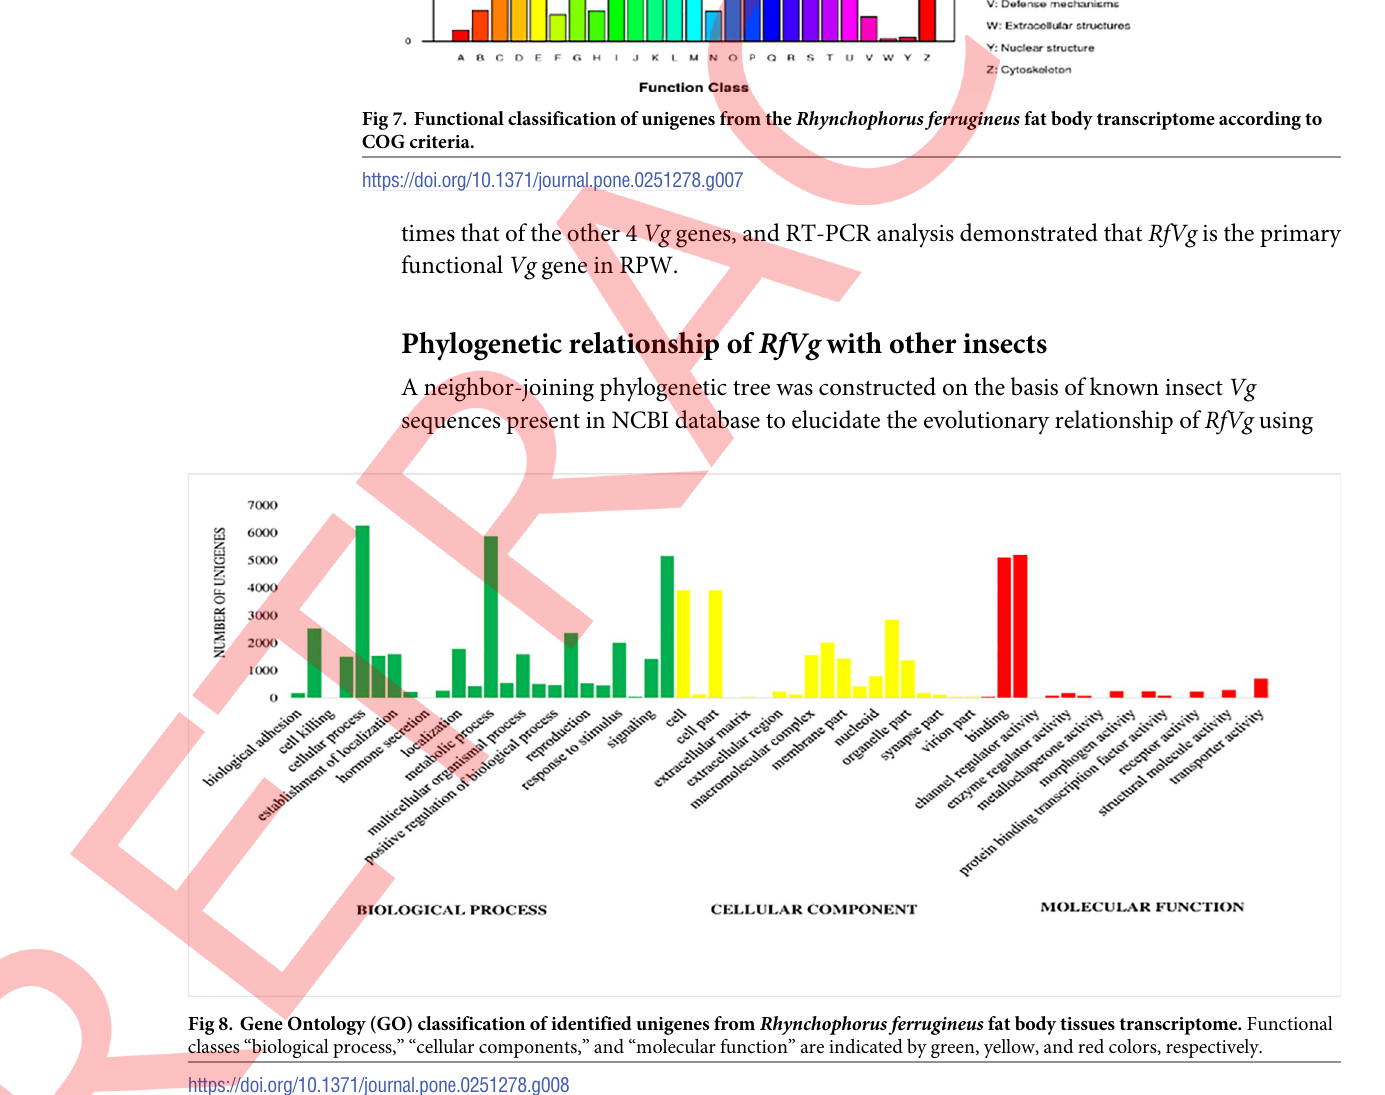
PLOS ONE | https://doi.org/10.1371/journal.pone.0251278 May 24,